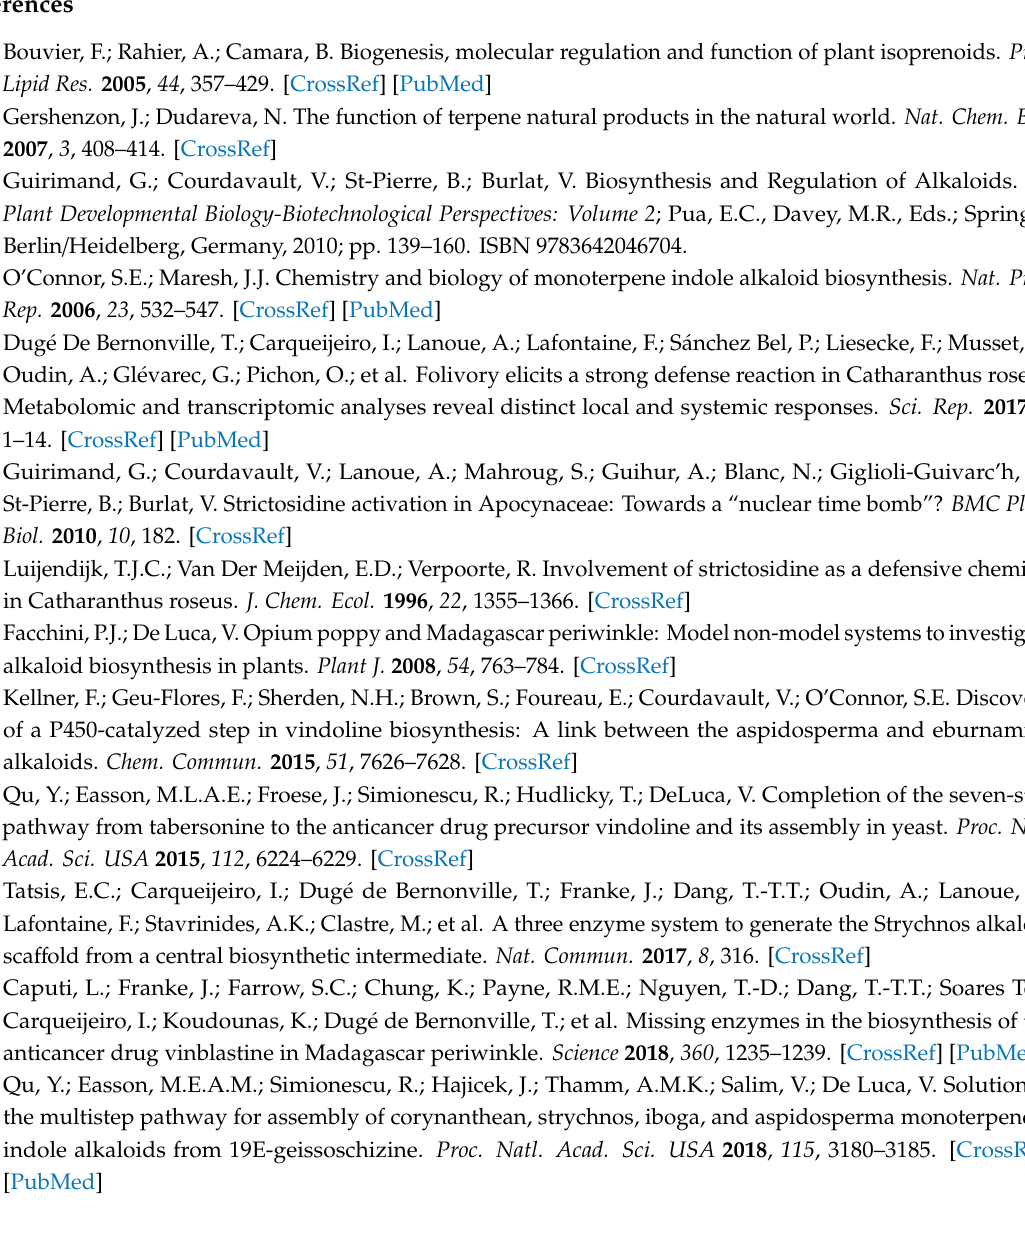
Table S6: Details of primer sequences and cloning procedures used to create internal YFP fusion for DXR and HDS. Table S7: Details of primer sequences and cloning procedures used to create plastid subcompartment CFP-markers; the CAB1 (chlorophyll a / b binding protein 1, At1g29930), TIC40 (translocon at the inner envelope of chloroplasts, At5g16620), CCD4 (carotenoid cleavage dioxygenase 4, At4g19170) proteins of A. thaliana were used as a marker of thylakoid, inner membrane of plastid and plastoglobules, respectively. The coding sequence of these proteins was amplified using retrotranscribed RNA extracted from A. thaliana as a